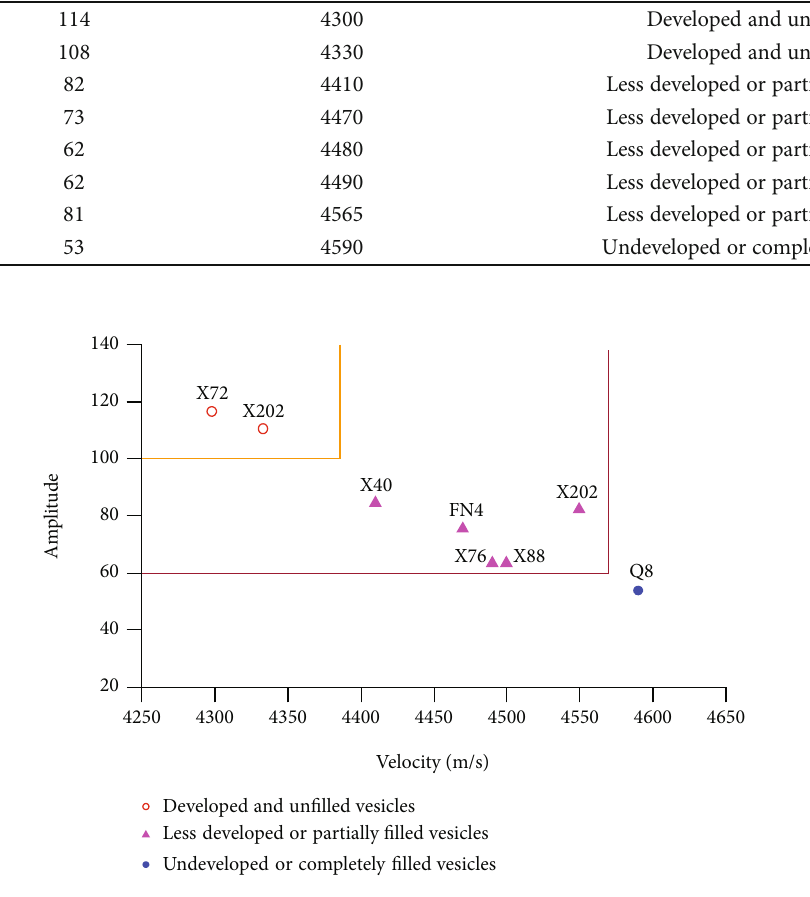
Figure 6: Cross plot of interval velocity and amplitude.